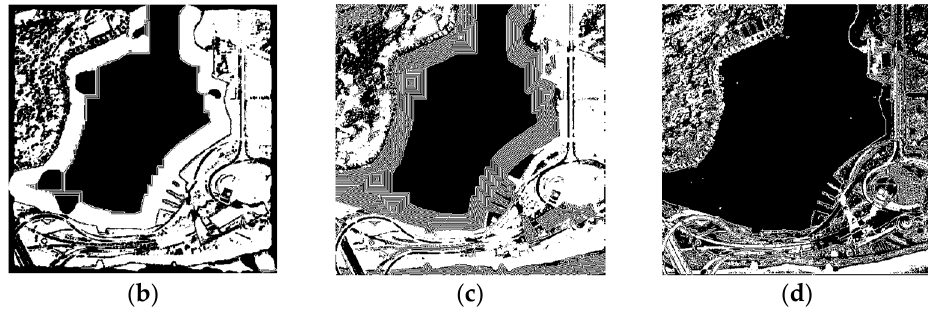
Figure 13. Segmentation results of WorldView-2 satellite remote sensing image 6: ( a ) original remote sensing image; ( b ) TPSCA–PCNN segmentation result; ( c ) PCNN segmentation result; ( d ) EML segmentation result.